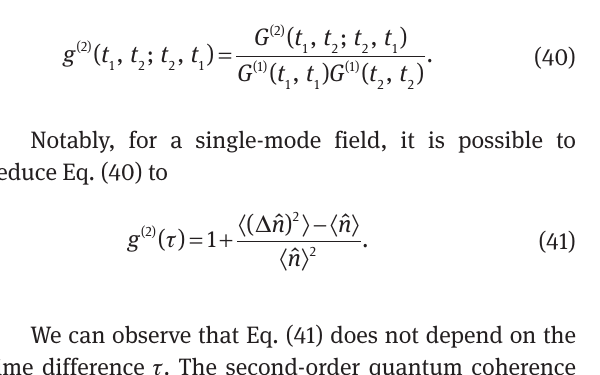
detectors D and D . The signals produced by the two detectors are 1 2 analyzed using a correlation